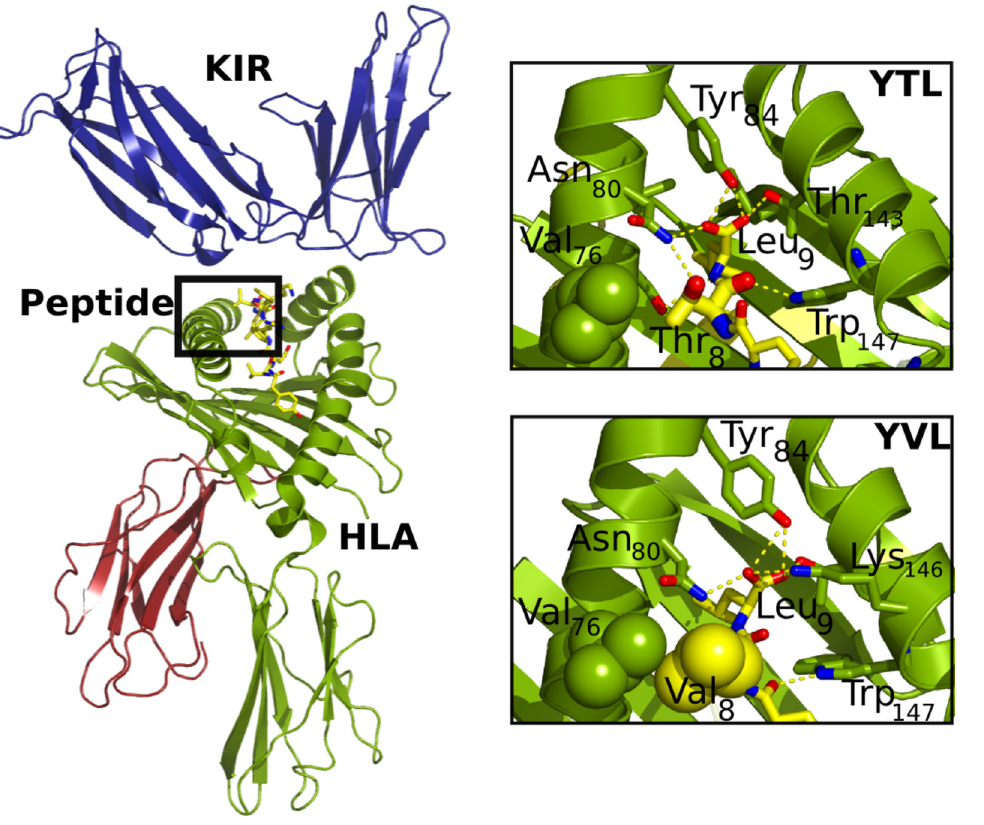
Fig 4. Structural details of the HLA/peptide/KIR three-way complex. (A) Overall structure of the HLA/peptide/KIR complex. The peptide is buried in the HLA class I binding grove, while KIR interacts with both helices of HLA class I as well as the C-terminus of the peptide. (B) Comparison of the interactions around the mutated viral residue (top: in fat sticks; bottom: in spheres). The YVDRFFKTL (YTL) wild-type peptide includes a hydrogen bond between the side-chain oxygens of Thr 8 and Asn 80 , while the YVDRFFKVL (YVL) variant improves the hydrophobic packing against Val 76 . Interestingly, Asn 80 participates in a hydrogen bond expected to confer allotype specificity to KIR2Ds.